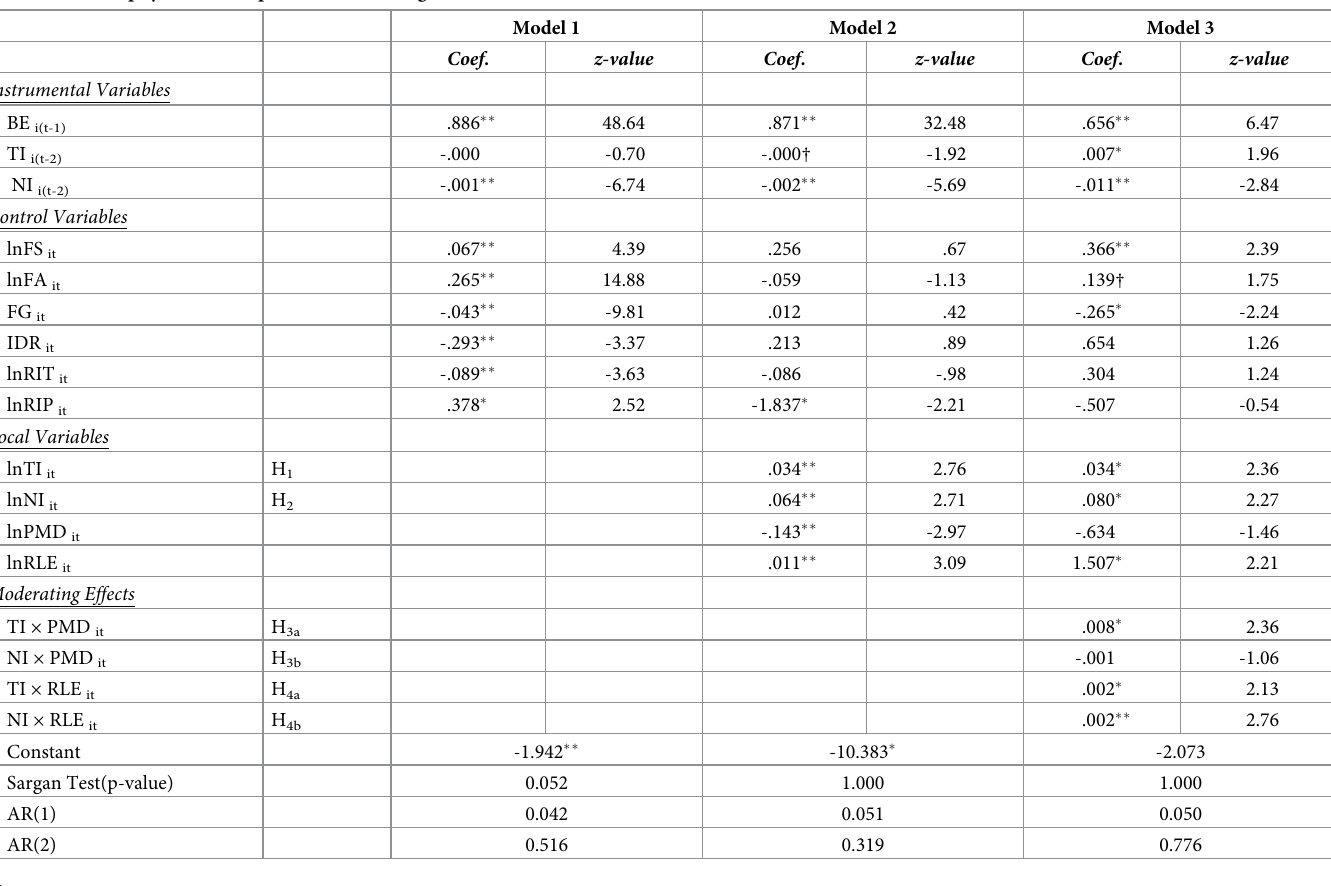
Table 4. Two-step system GMM panel estimation